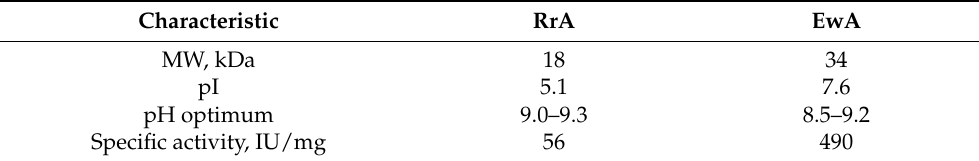
Table 3. Comparative characteristics of L-asparaginases from Rhodospirillum rubrum and Erwinia carotovora [23,24].